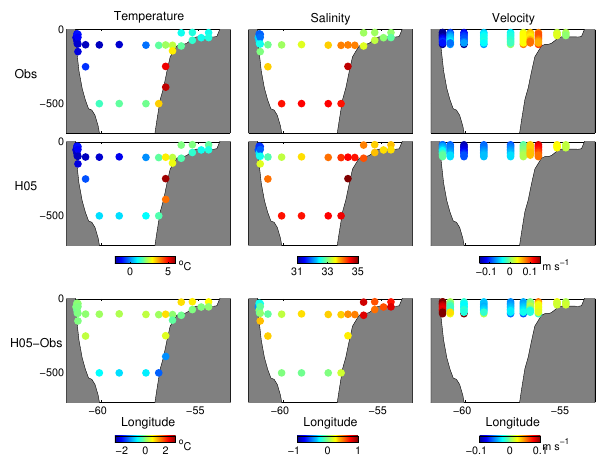
Figure 11. As for Fig. 10 but for Davis